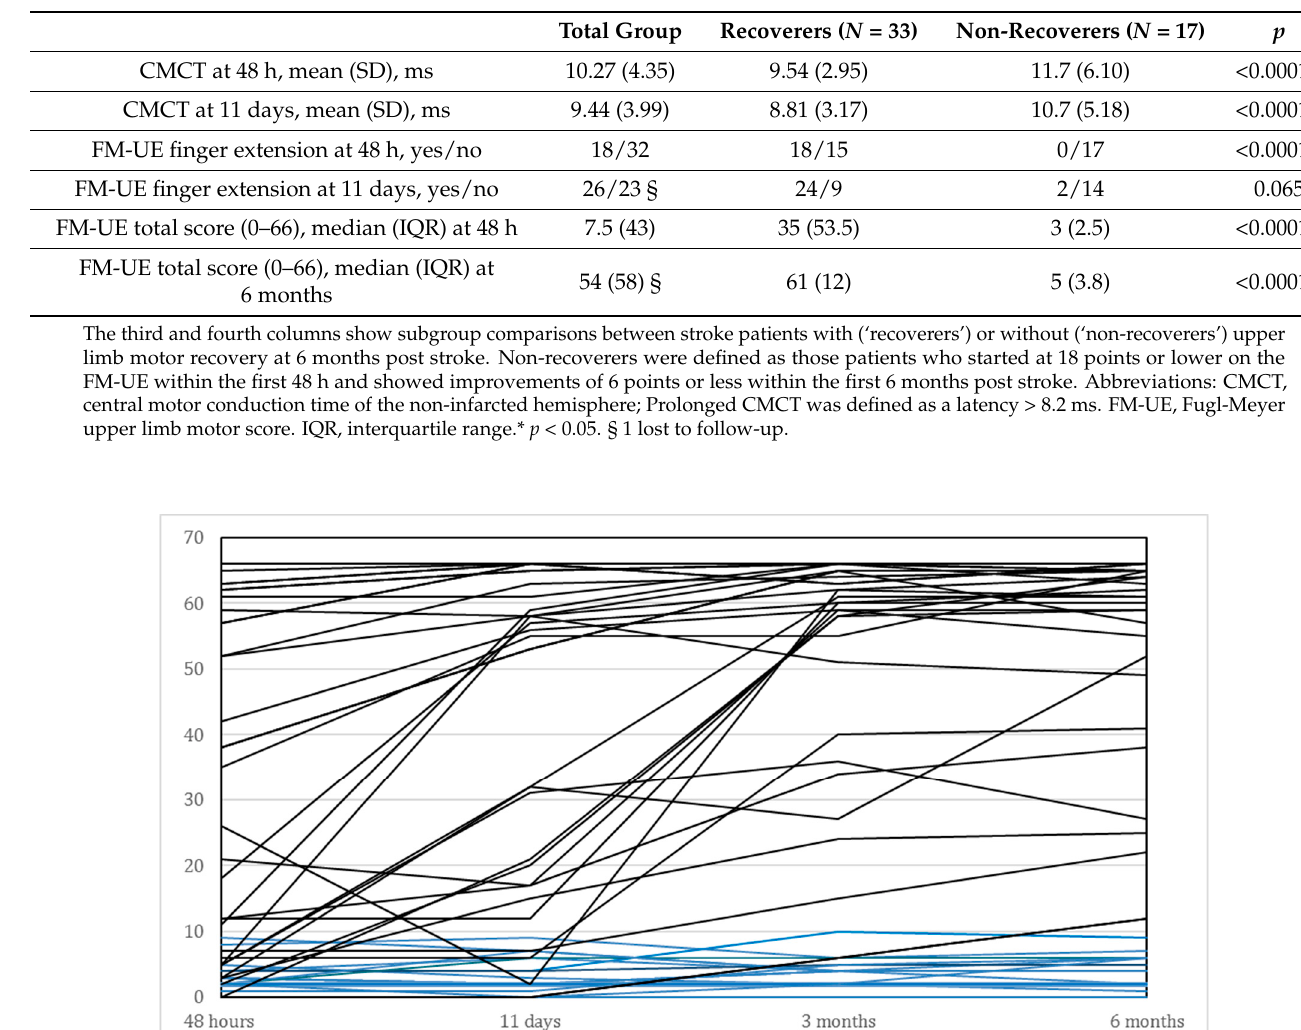
Table 2. Transcranial Magnetic Stimulation and Fugl-Meyer upper extremity score characteristics for the total group ( N = 50, second column), and subgroups (third and fourth columns) in relation to spontaneous neurological upper limb motor recovery after stroke.